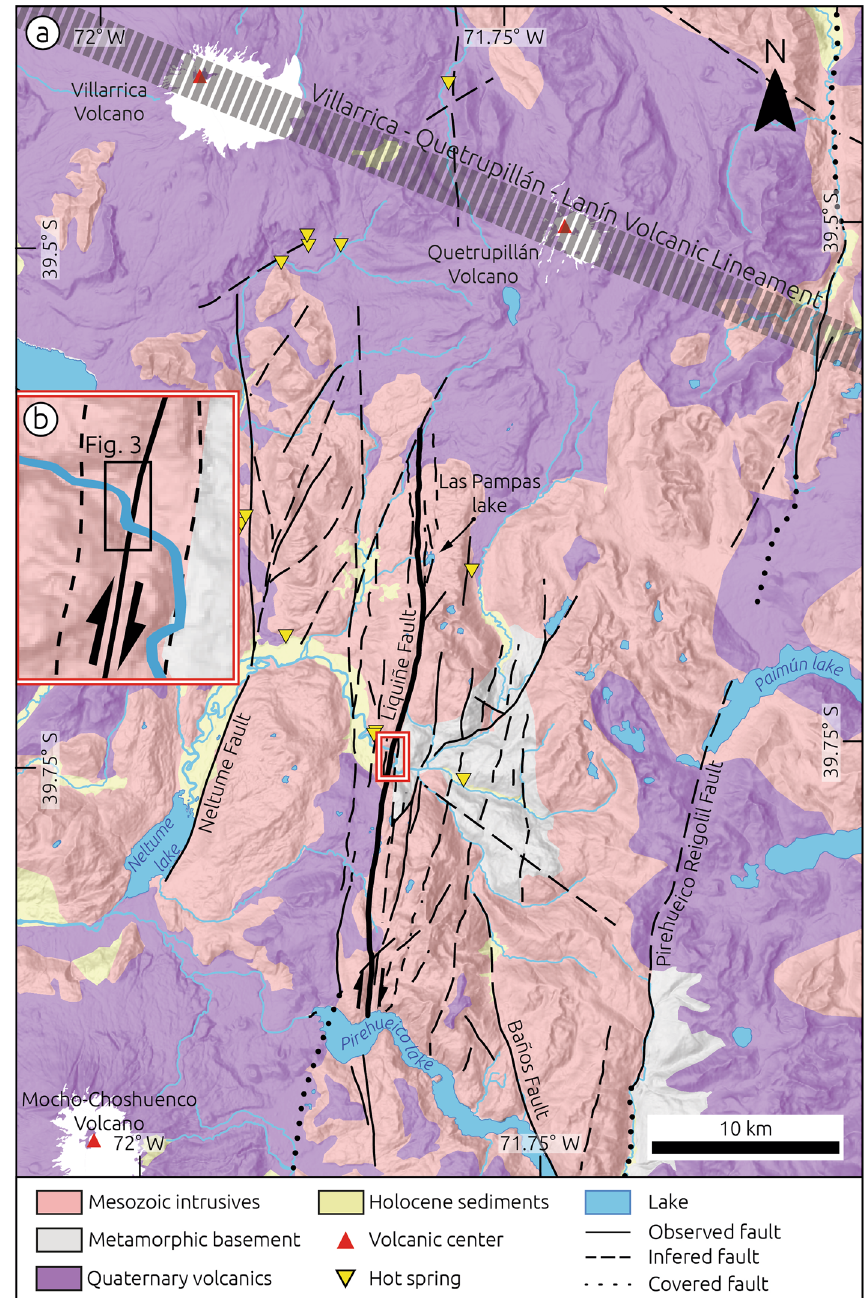
Figure 2. Geologic map of the Liquiñe region (modified from Ref. 40 ). Faults from the CHAF database 20 . Thick black line denotes the Liquiñe Fault. ( b ) Detailed view of the Liquiñe Site, note marked deflection of the Liquiñe